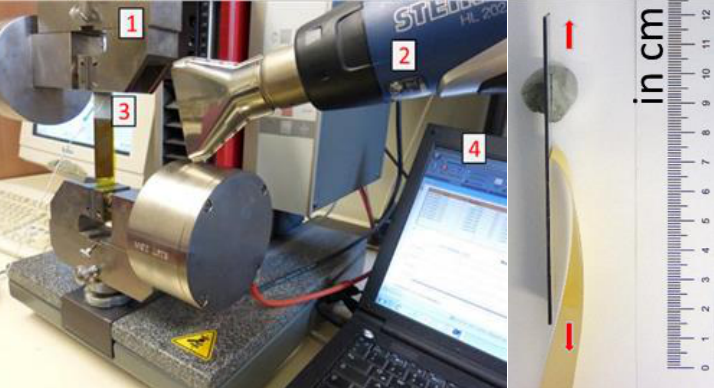
Figure 5. Setup of the 180-degree peel test (1—tensile testing machine Zwick 2.5, 2—hot air blower, 3—tested sample with type K thermocouple, 4—laptop for temperature measurement and control).